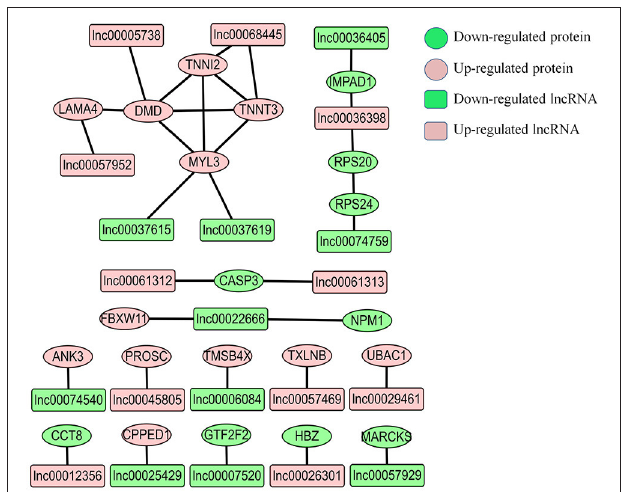
FIGURE 7 | Proteins-lncRNA network for comparison group of E11 vs. D1. The predicted potential target genes of differentially expressed lncRNAs compared with corresponding differentially expressed proteins. The pink circles represent up-regulated proteins, and the green circles represent down-regulated proteins. The pink rectangles represent up-regulated lncRNAs, and the green rectangles represent down-regulated lncRNAs.